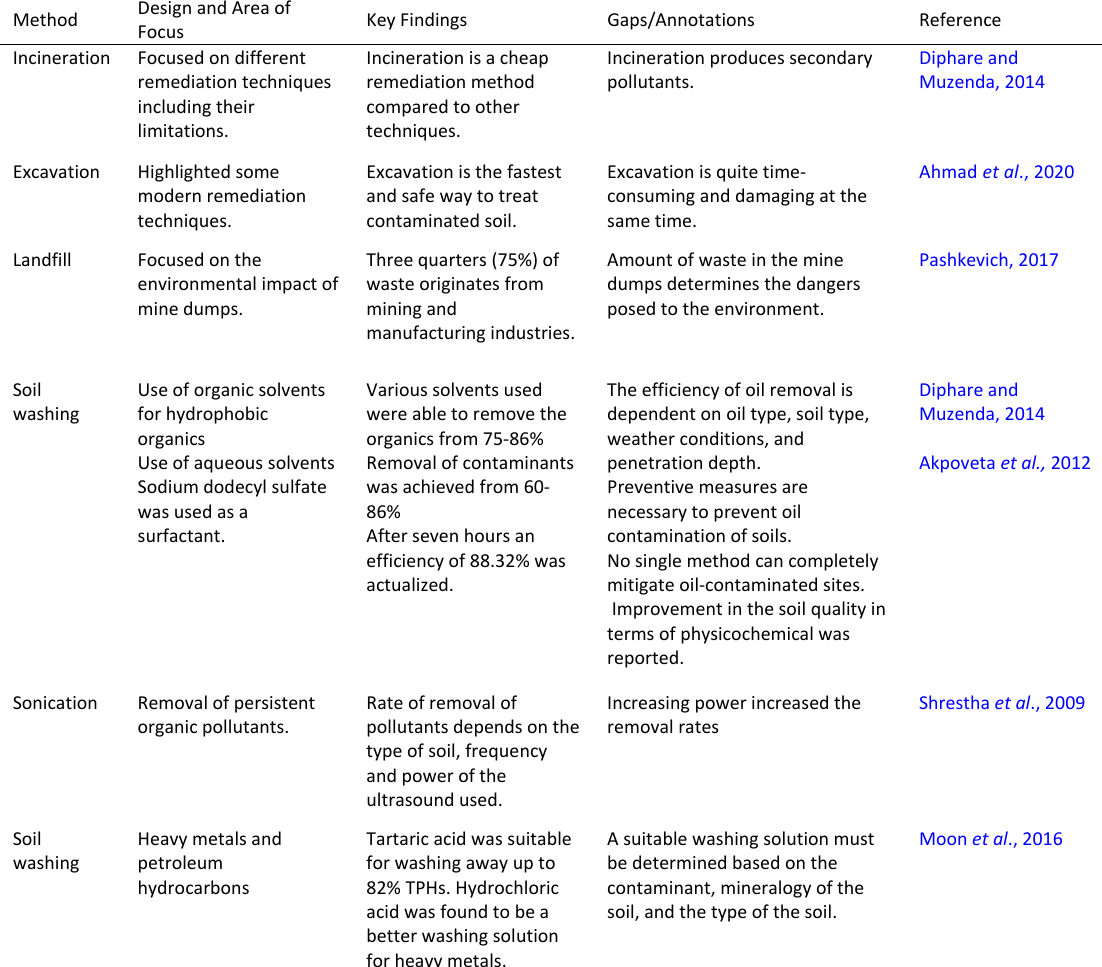
Table 3: Comparison of key findings and disadvantages associated with different physical methods of oil remediation Method